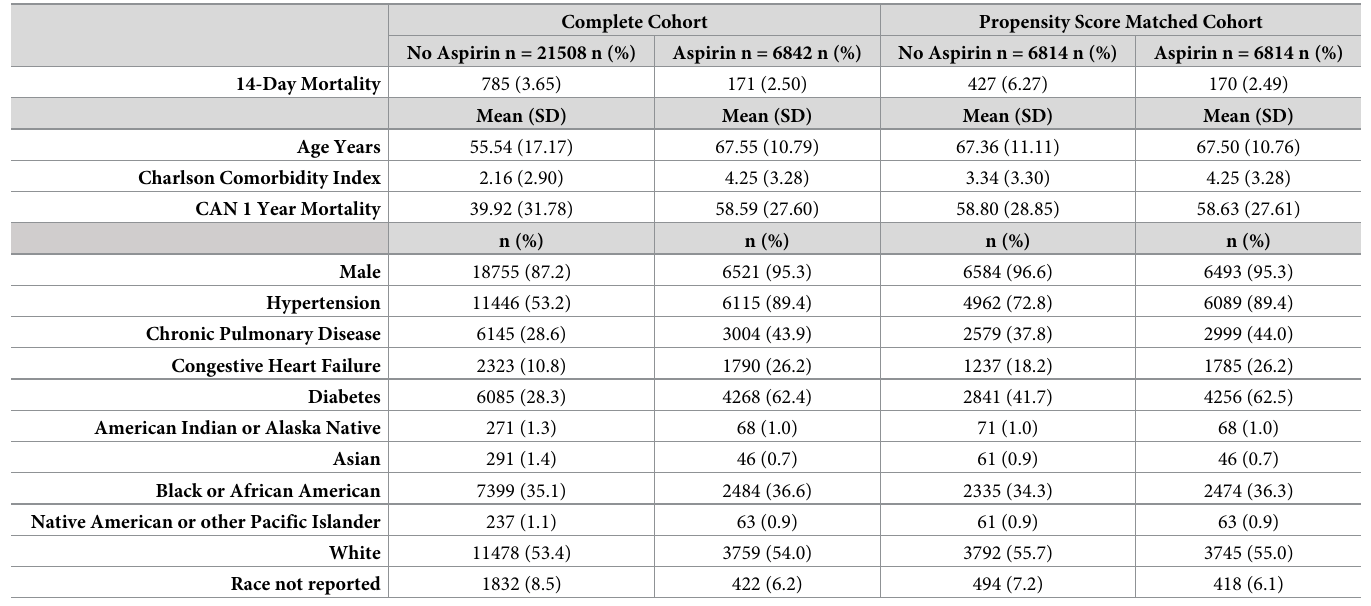
Table 2. Patient characteristics for the 14-day mortality assessment cohort before and after propensity score matching.